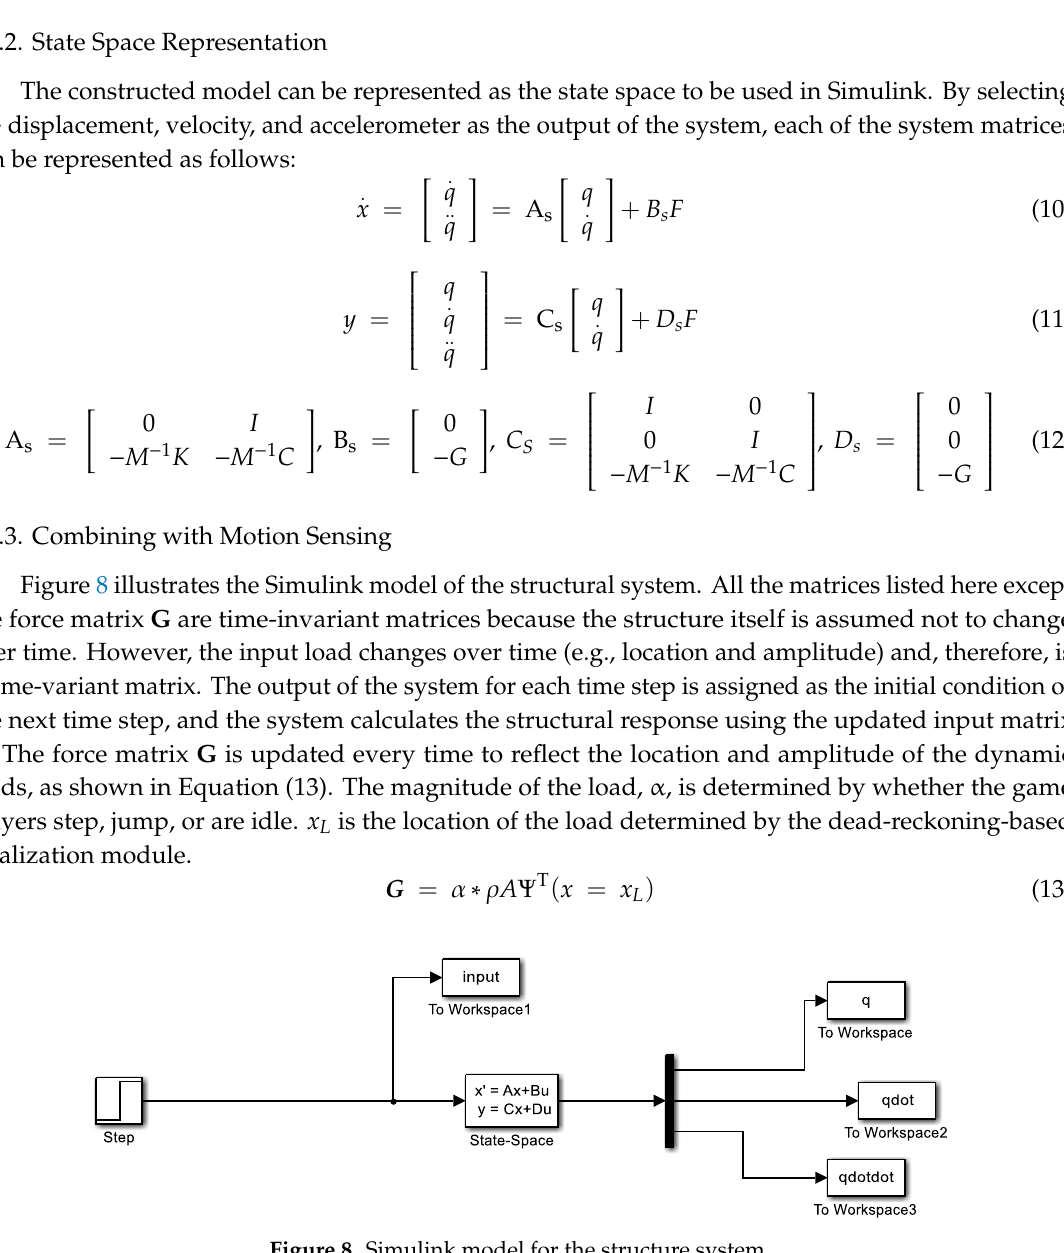
Figure 8. Simulink model for the structure system.